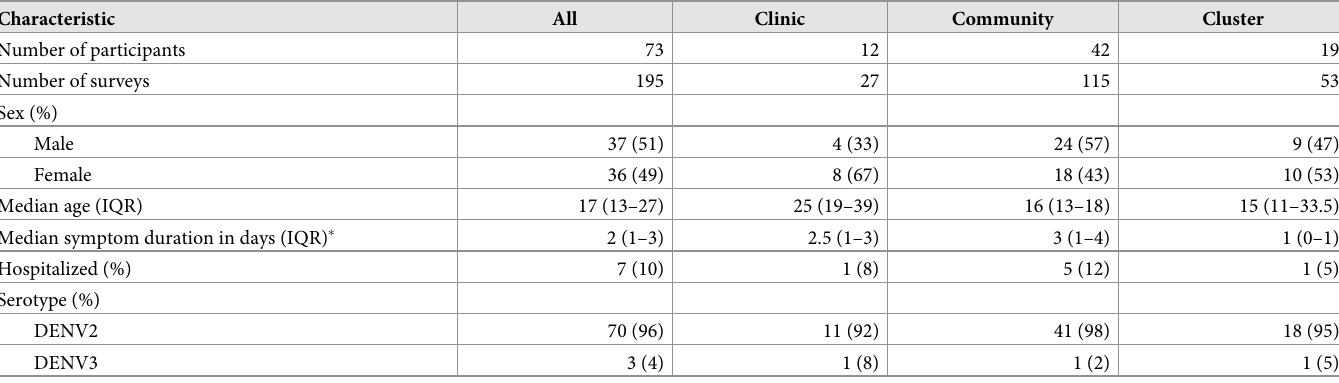
Table 1. Participant